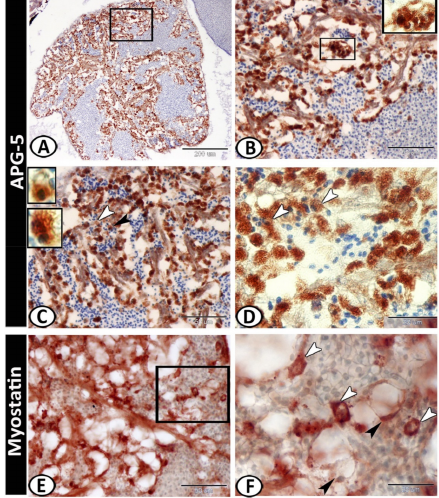
Figure 5. Immunohistochemistry of APG5 and Myostatin in the spleen. ( A ) The white pulp of the spleen expressed APG5 (boxed area). ( B ) APG5 expressions were well distinct in the melanomacrophages (boxed areas). ( C ) Leukocytes (boxed areas, arrowheads) expressed APG5. ( D ) Macrophages (arrowheads) also expressed APG5. ( E , F ) Myostatin was expressed in the leuko- cytes (white arrowheads) and epithelial reticular cells (black